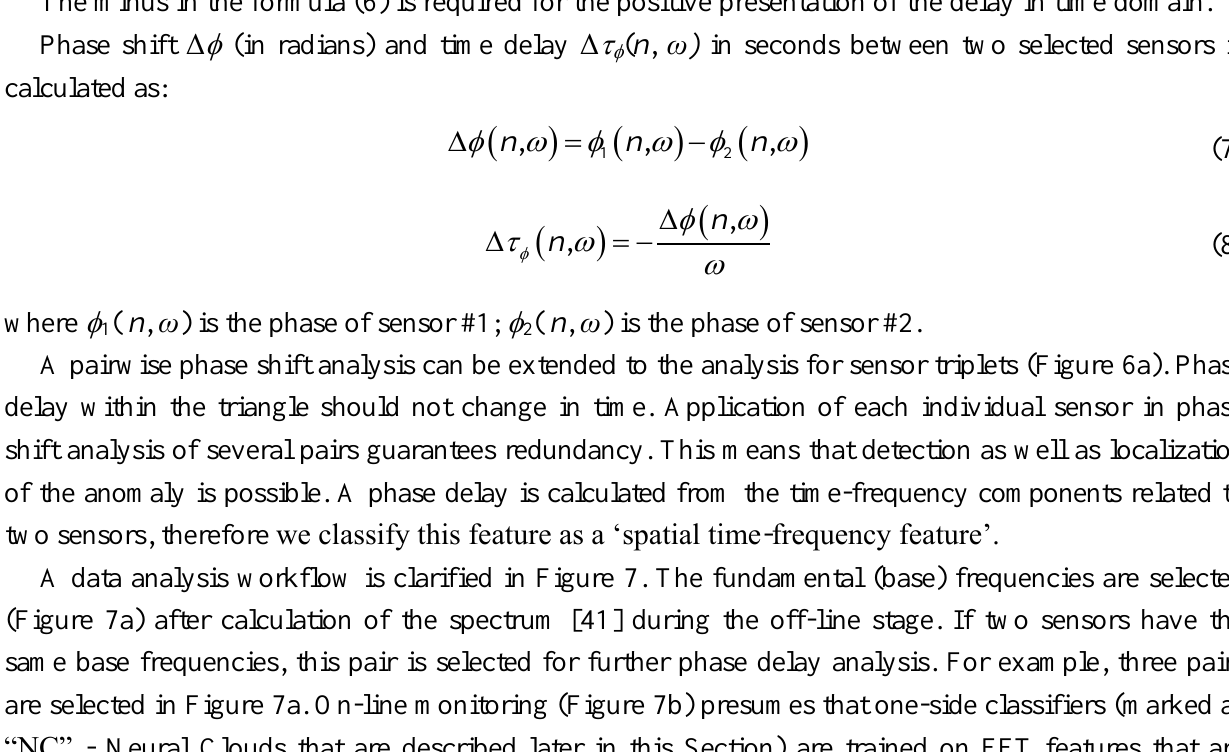
Figure 7. ( a ) Selection of pairs of FFT components for phase delay analysis in off-line mode. ( b ) On-line procedure of condition monitoring based on phase delay